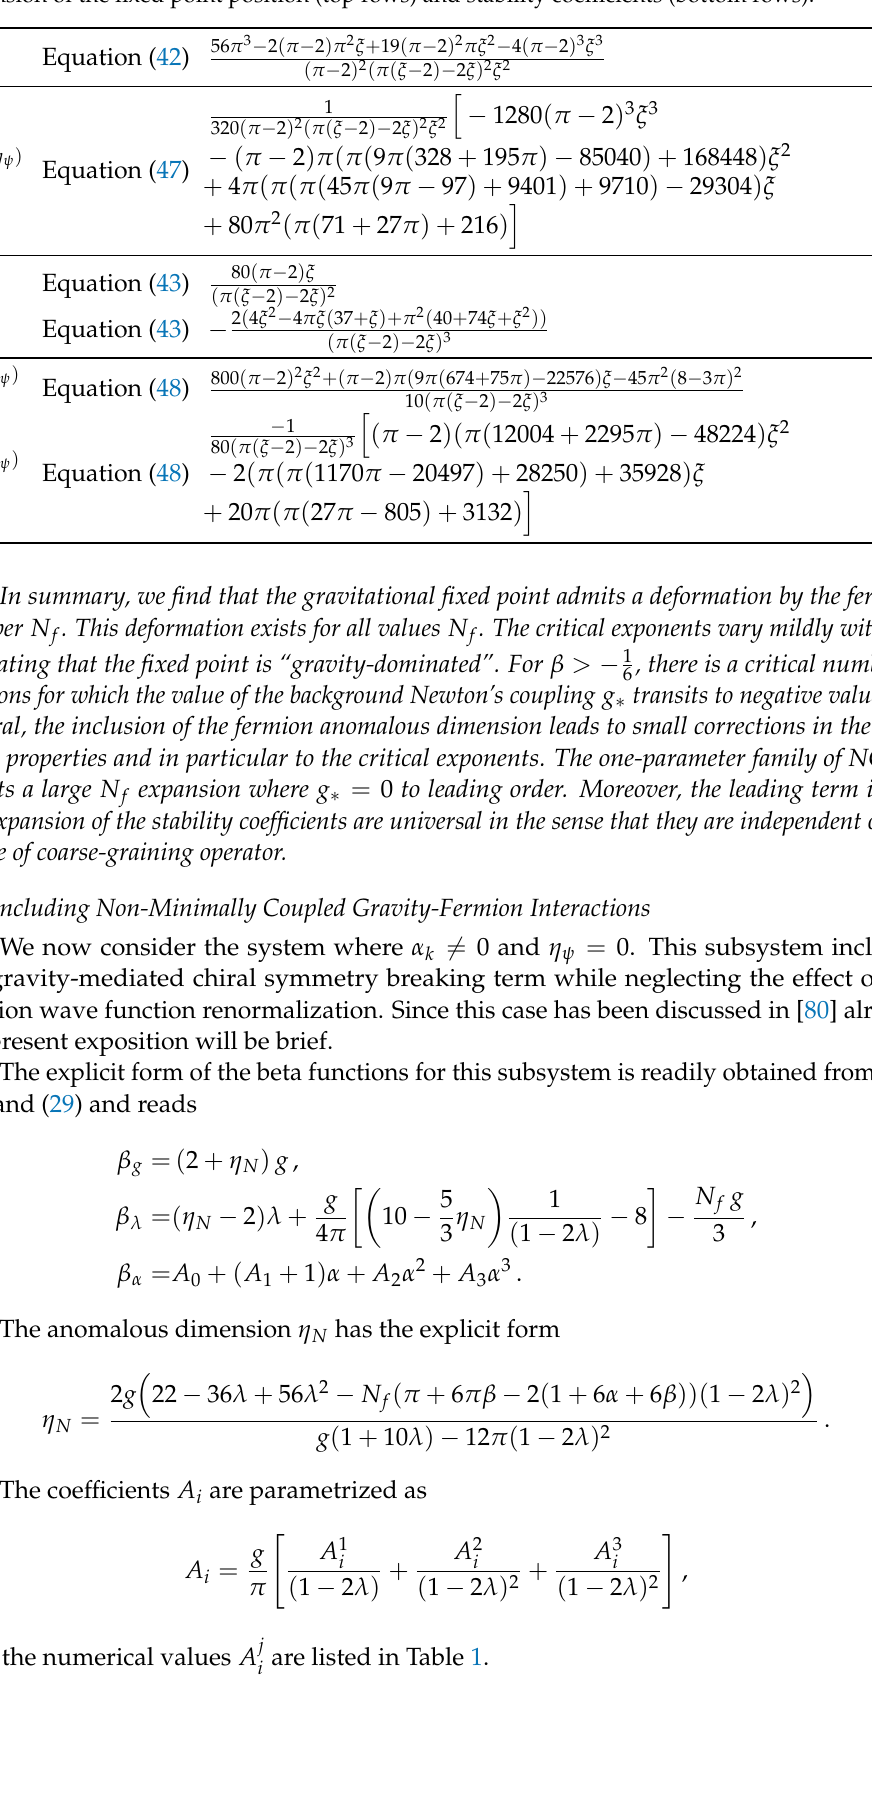
Table 2. Summary of the numerical coefficients determining the leading corrections in a large- N f expansion of the fixed point position (top rows) and stability coefficients (bottom